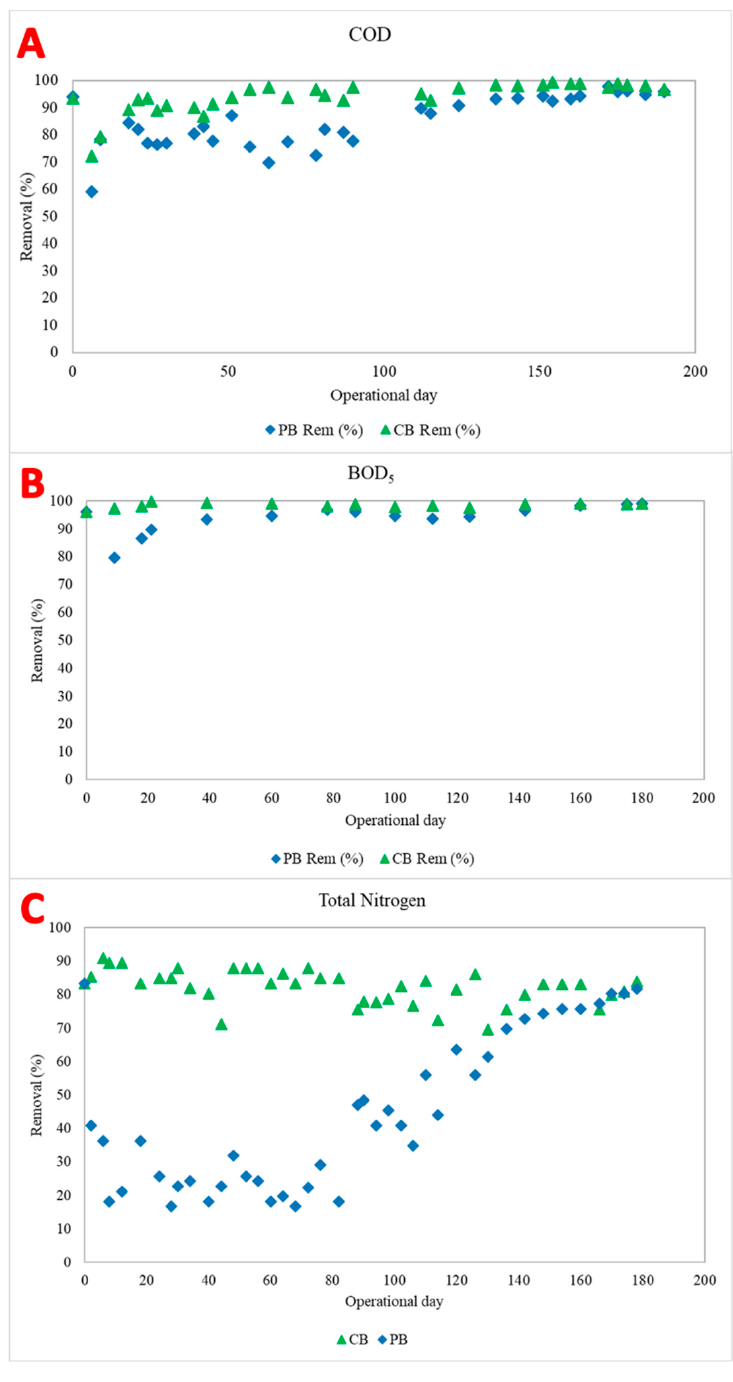
Figure 3. Chemical oxygen demand removal ratio ( A ); biological oxygen demand removal ratio ( B ); and nitrogen removal ( C ) for the control reactor (green triangle) and pharmaceutical reactor (blue diamond).